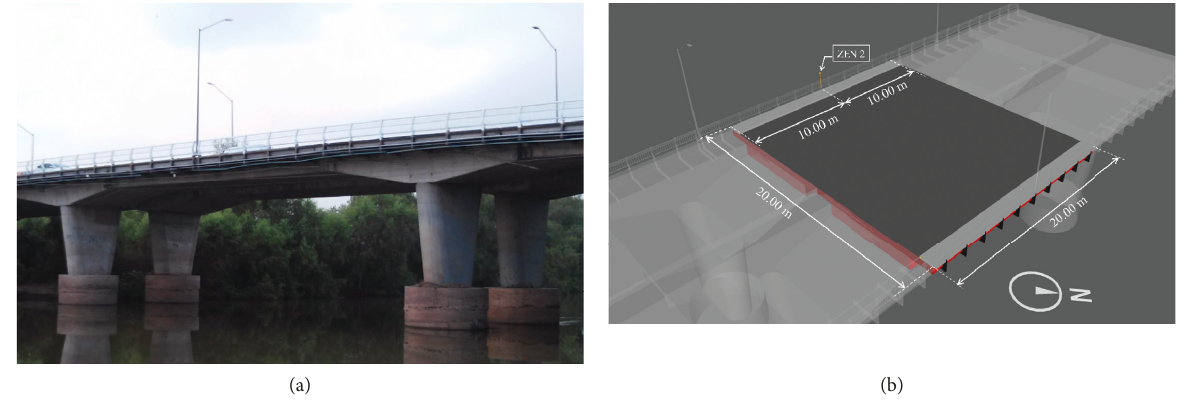
Figure 5: Juarez Bridge: (a) lateral view; (b) ZEN2 GPS